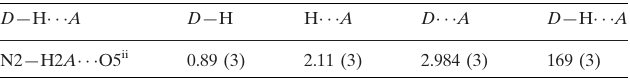
Hydrogen-bond geometry (A˚ , (cid:3)